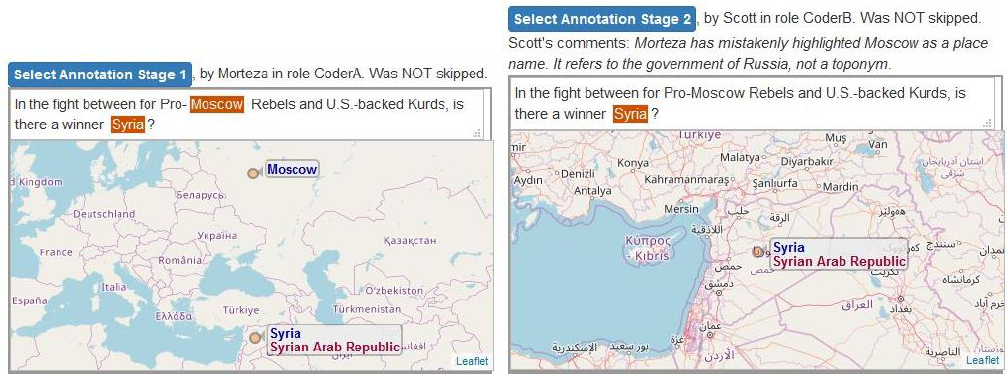
Figure 6. Annotation history window. Coders (users) can see previous geo-annotations of the same document (along with submitted explanatory comments) by themselves and the other coder of that document. The “select annotation” button populates the main window with annotations from any stage.